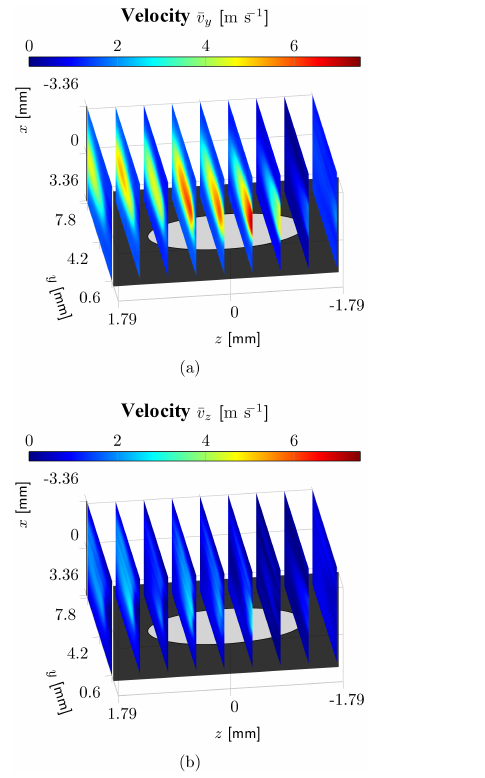
Figure 7. Mean flow velocity (a) ¯ v y in y direction and (b) ¯ v z in z